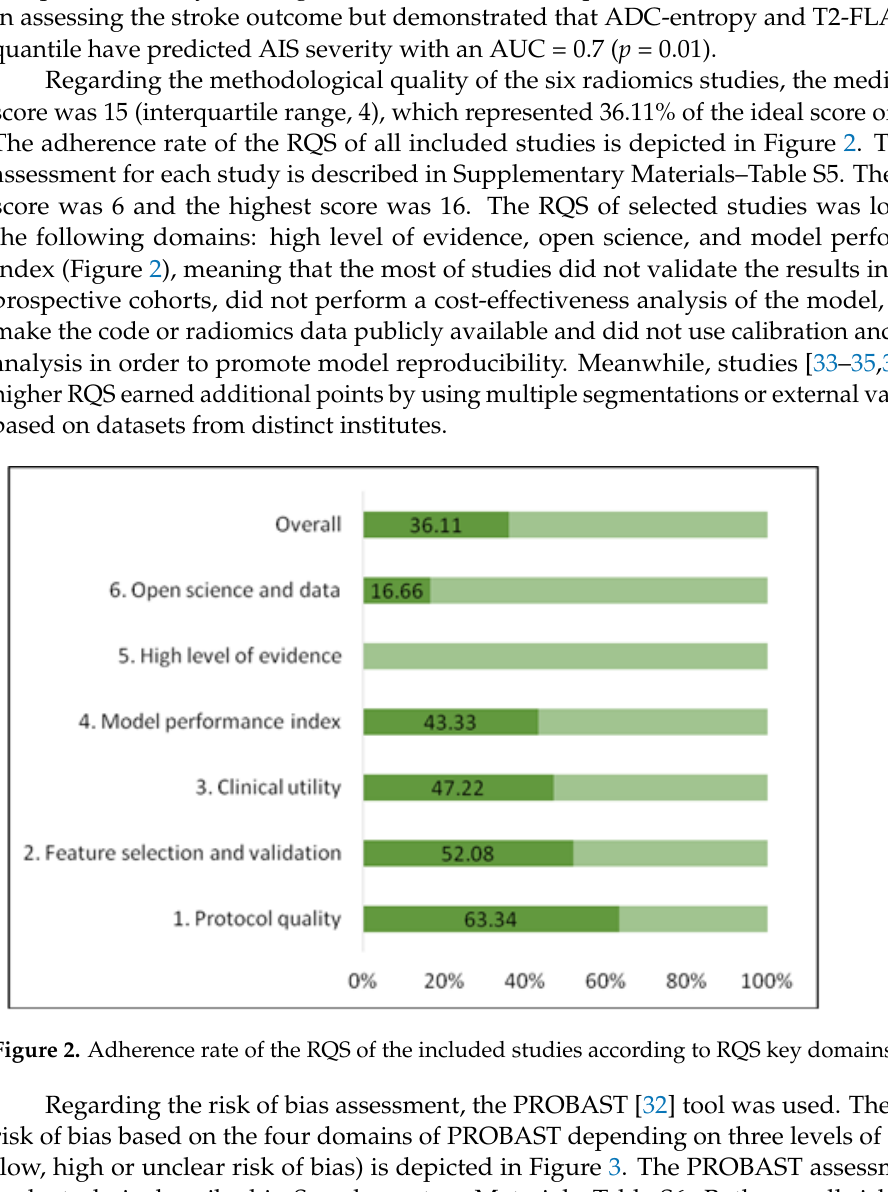
Figure 3. Methodological quality of the studies included according to PROBAST tool for risk of bias and applicability concerns. 4. Discussion Prognostic scores may not fit to all cohorts due to patients’ differences regarding ra- cial or ethnic identity, background or comorbidities, hospital type or healthcare sys tem, and acute stroke management [40] . Poststroke functional outcome is affected by a variety